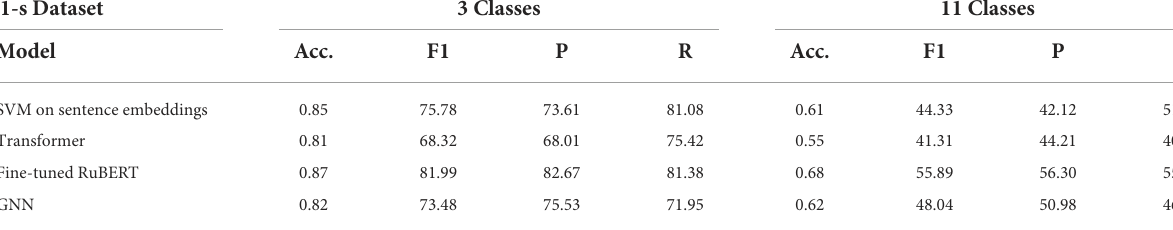
TABLE 6 Classification of sentences with 3 and 11 complexity